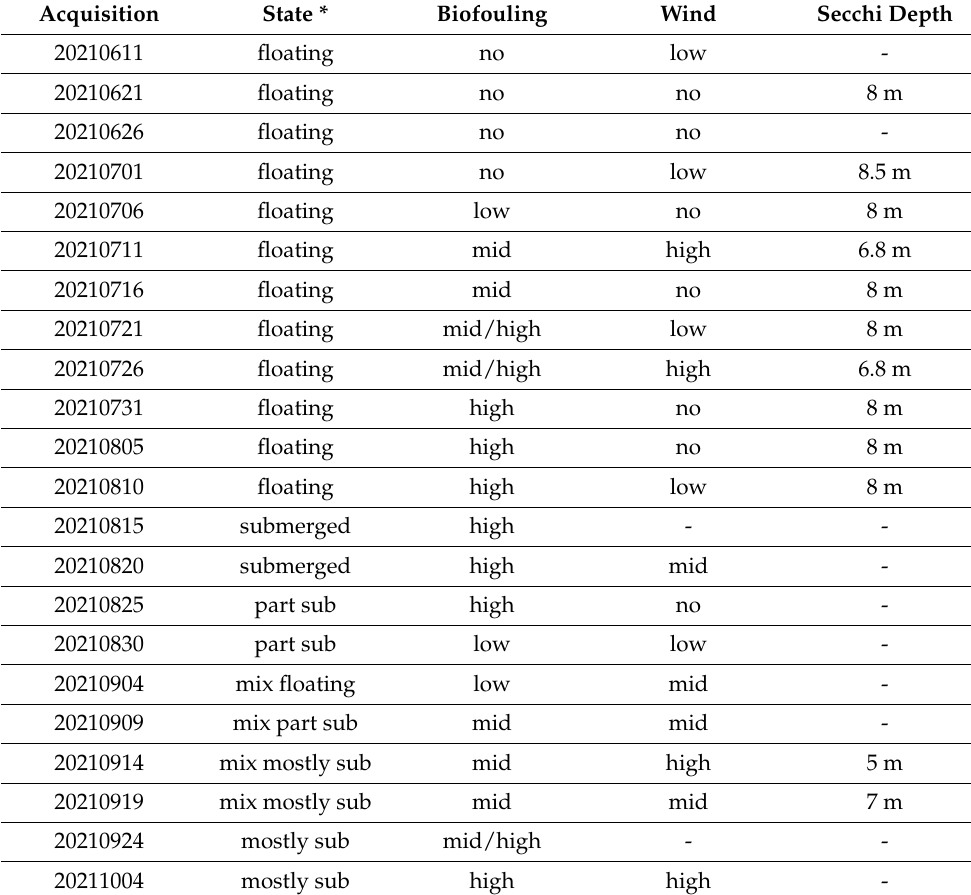
Table 1. State of target and environmental conditions for each